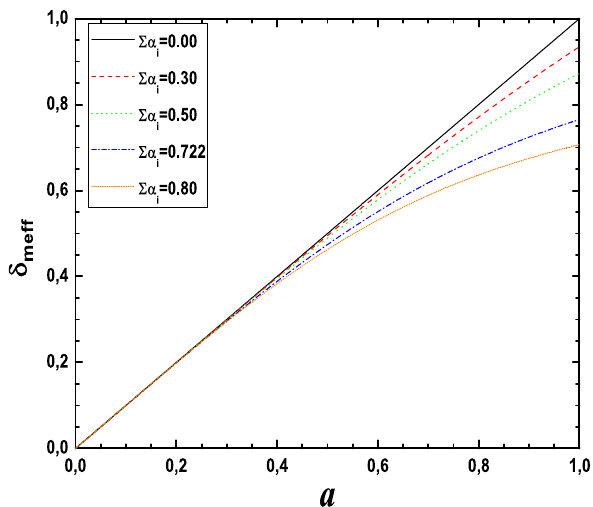
Fig. 1 Evolutionoftheeffectivematterdensitycontrastintheextended CCDM model (for different values of α ef f as a function of the scale factor. The blue line is obtained for the best fit value from SNe Ia data to the unique effective free parameter, α ef f = α dm + α b . It reproduces exactly the standard (cid:2) CDM prediction for the nonrelativistic density contrast and also to the transition redshift. Note that δ ( mef f ) describes only that portion of the created nonrelativistic components (baryons + CDM), which is able to appear as clustered matter. This extended CCDM model is different from [52,55] since it also includes the created subdominant components (CMB + neutrinos) thereby slightly changing the temperature law and others relevant properties of the photon-baryon